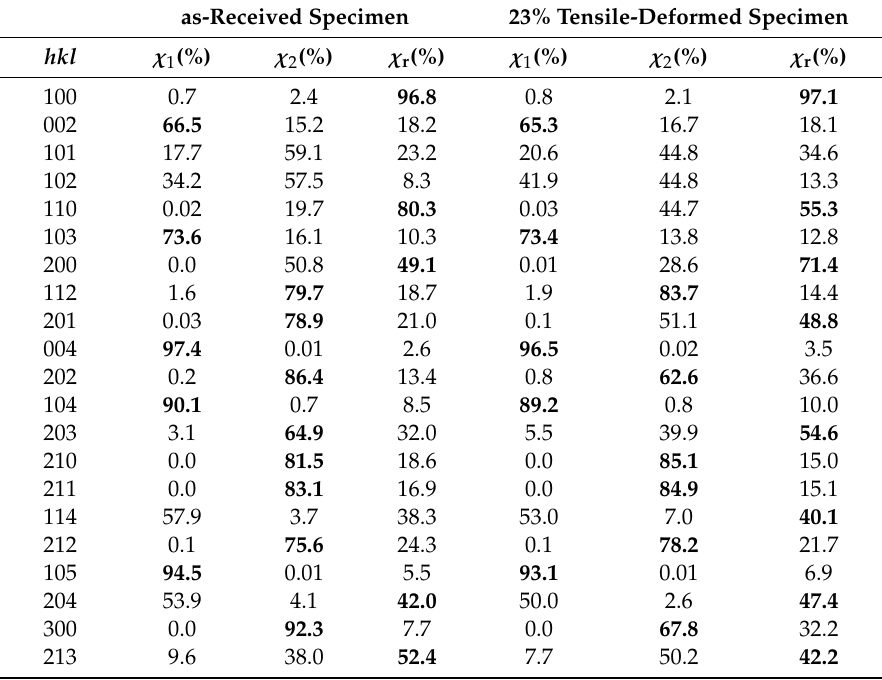
Table 3. χ values of the two major texture components (with Φ > 0 for component #1 and Φ < 0 for component #2) and the random texture component for di ff erent hkl di ff raction peaks in the case of the as-received and the 23% tensile-deformed specimens corresponding to the ND-A measurement. The bold numbers indicate to which texture component and, hence, to which quasi-phase the peaks are assigned to in the CMWP fitting